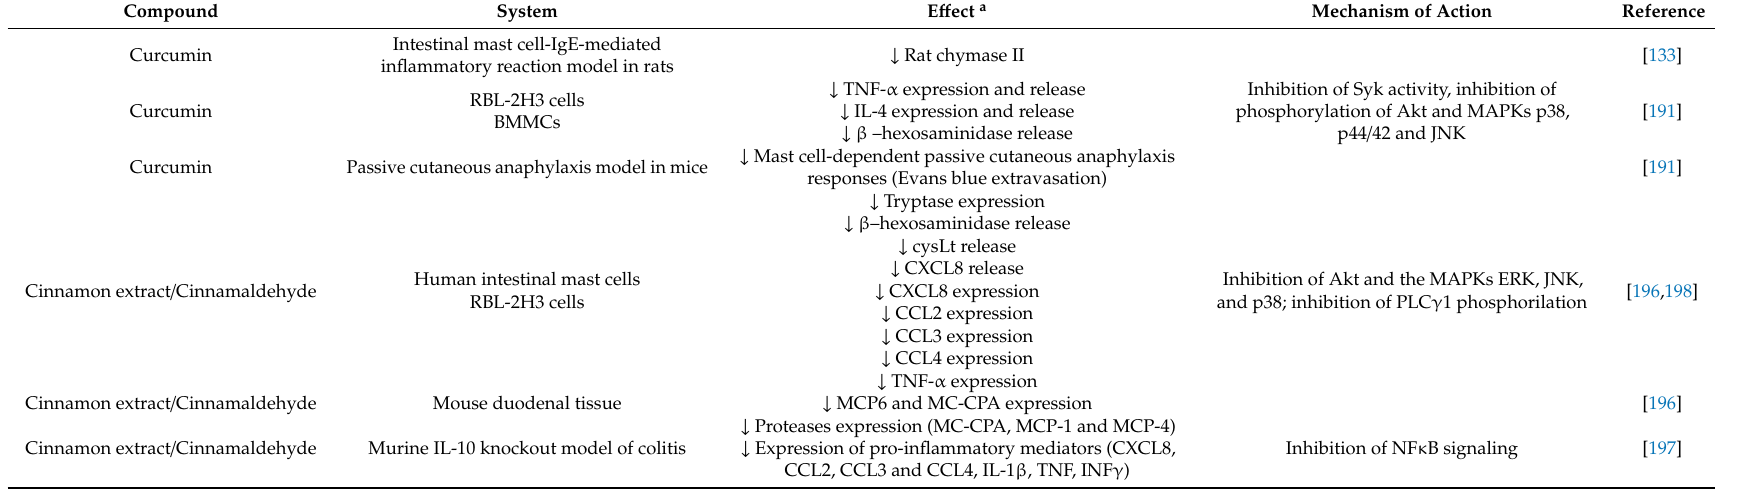
Table 8. Immunomodulatory e ff ects of spices on mast cell